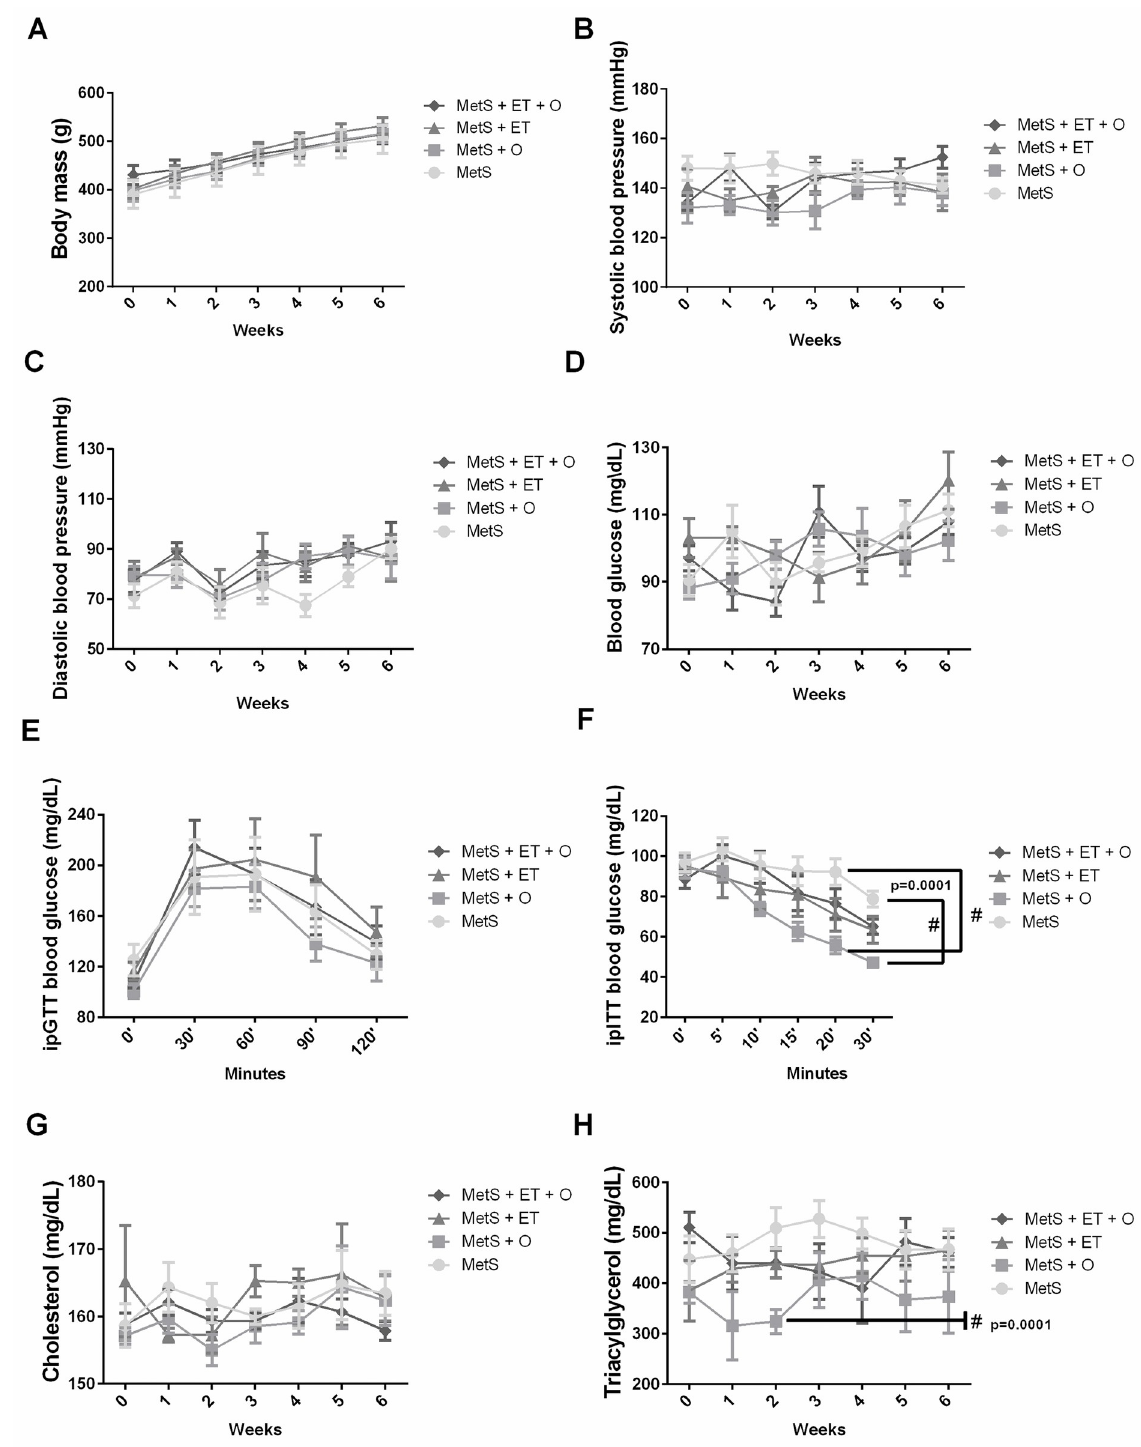
Fig 2. MetS diagnostic parameters—MetS group. (A) body mass (g), (B) systolic blood pressure (mmHg), (C) diastolic blood pressure (mmHg), (D) blood glucose (mg/dL), (E) ipGTT (minutes), (F) ipITT (minutes) (p = 0.0001), (G) cholesterol (mg/dL), (H) Triacylglycerol (mg/dL) (p = 0.0001). # vs. MetS. Statistic: Two-Way ANOVA, p < 0.05.